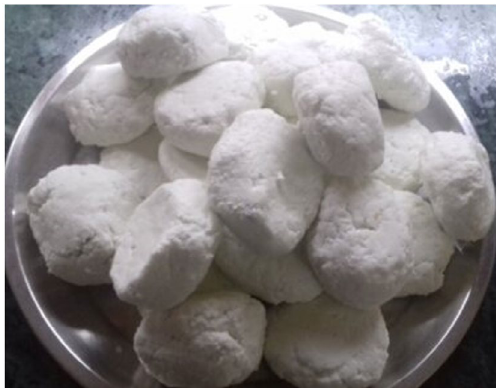
Fig. 1. Kaladhi - A traditional fermented food of North- West Himalayas